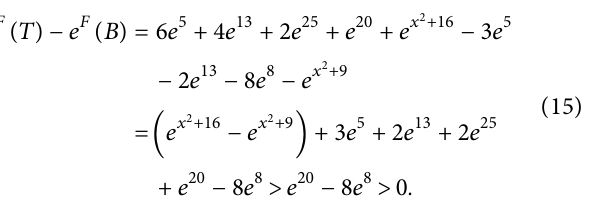
Figure 13: The trees T and B